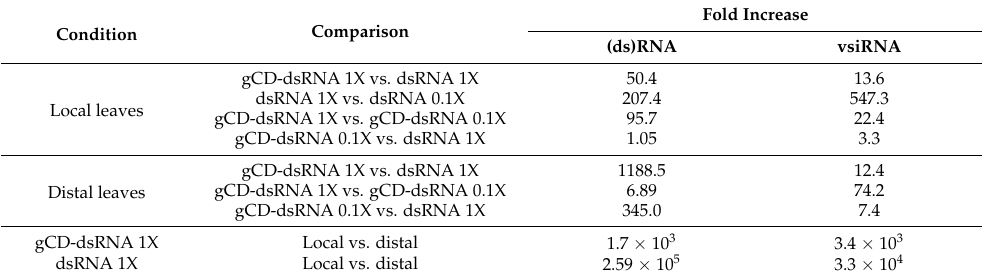
Figure 7. Quantitation of (ds)RNA in leaves after 3 dpt of the application of the gCD-dsRNA or naked dsRNA in local ( A ) and distal leaves ( C ). Quantitation of the derived 6125-vsiRNA in local samples ( B ) and distal leaves ( D ). Each boxplot shows the median (horizontal line), first and third quartiles (lower and upper limits of boxes), and the minimum and maximum values (delimited by the external whiskers). Mean values are indicated by crosses. Table 1. Comparisons of fold changes in the quantitation of (ds)RNA and 6125-vsiRNA in the site of application and on distal leaves after spraying dsRNA, 0.1X dsRNA, gCD-dsRNA or 0.1X